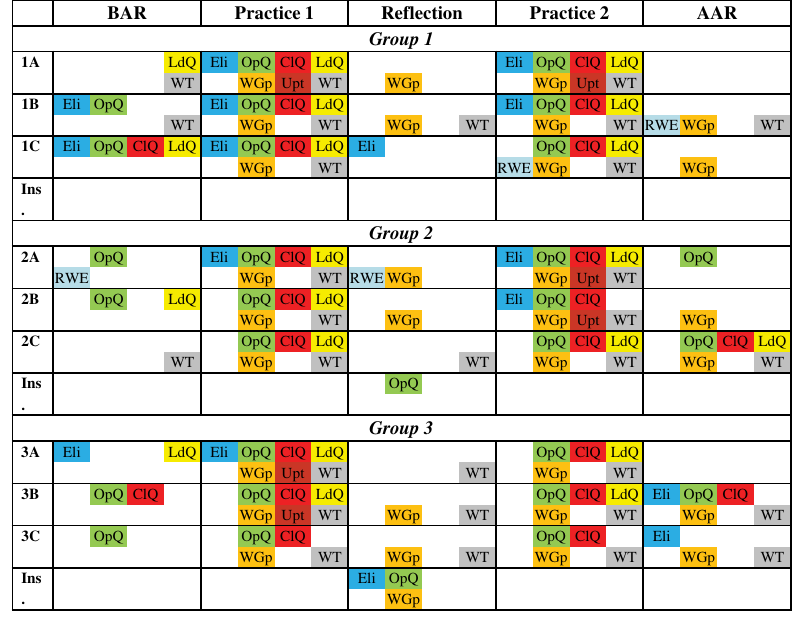
FIG. 5. Observed pedagogical skills. We observed LAs practicing the full range of identified pedagogical skills in the classroom simulator.